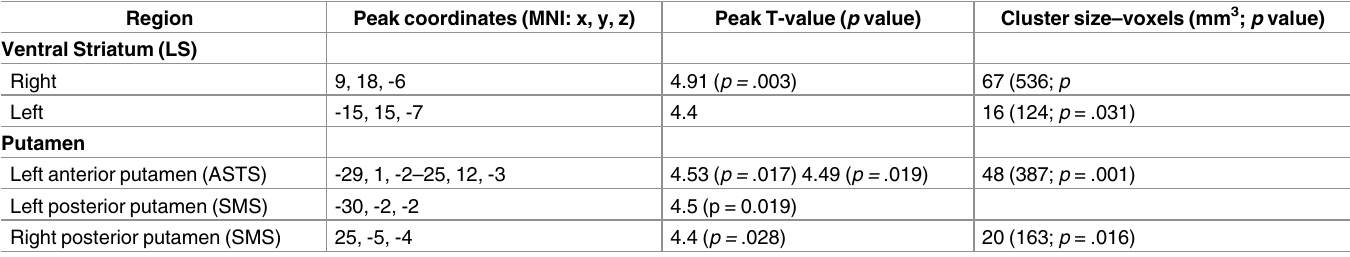
Table 5. Voxel-wise analysis of [ 11 C]raclopride binding potential (BP ND ) difference values between placebo/baseline and amphetamine. Region Peak coordinates (MNI: x, y, z) Peak T-value ( p value) Cluster size–voxels (mm 3 ; p